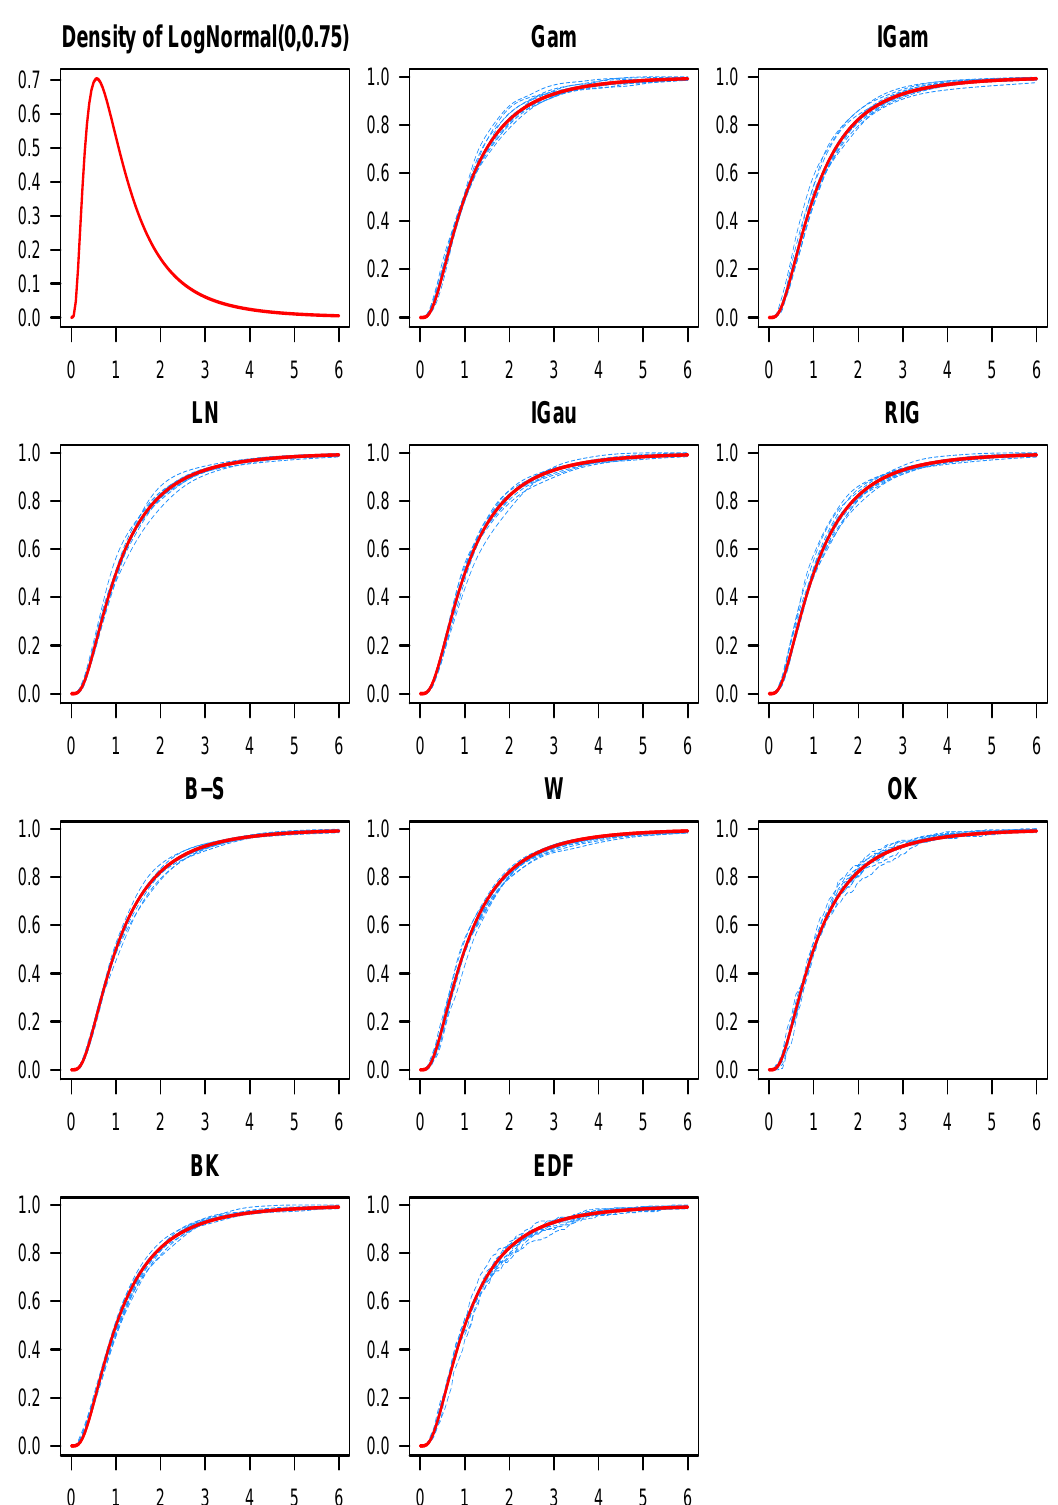
Figure 7. The LogNormal ( 0,0.75 ) density function appears on the top-left, and the target c.d.f. is depicted in red everywhere else. Each plot has ten estimates in blue for the LogNormal ( 0,0.75 ) c.d.f. using one of the ten estimators (the name of the corresponding kernel is indicated above each graph) and n =